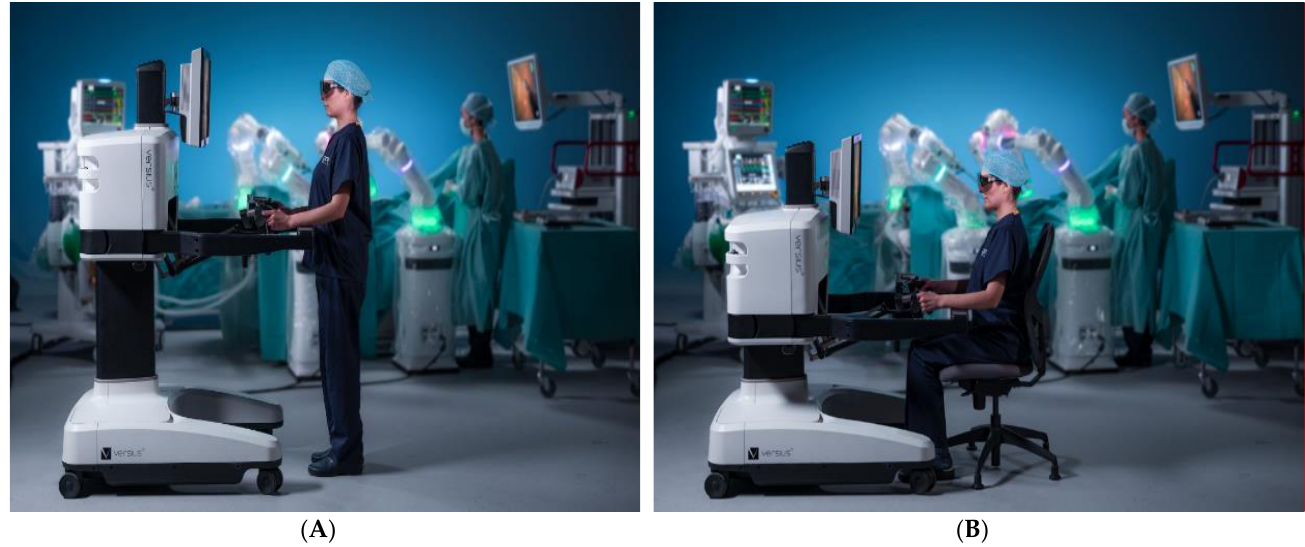
Figure 1. Versius surgical robotic system: ( A ) the surgeon at the console in standing and ( B ) sitting position.